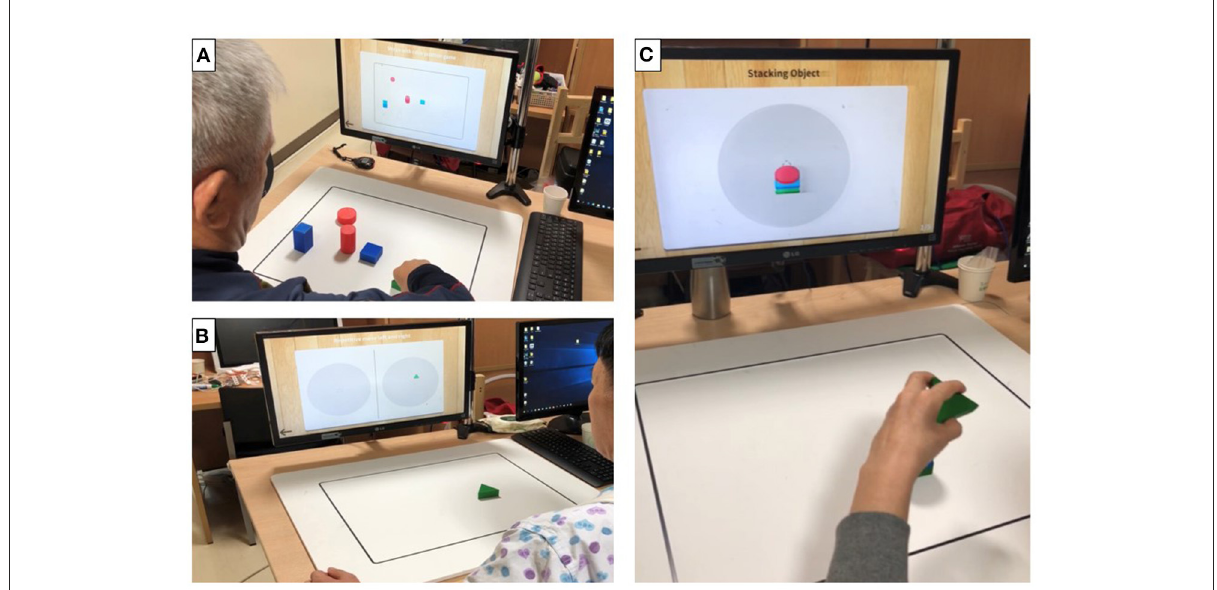
FIGURE3 Photographs of actual training using the objects in mixed reality (MR)-board training. The photographs show actual training using objects. Visual feedback was provided to the patients through a monitor that reflected the position of the object on the board. (A) “Matching the same shape” involved positioning of six objects correctly while comparing those displayed on the monitor. (B) “Moving the object” involved moving specific objects to the right and left repetitively. (C) “Stacking the objects” involved stacking objects on top of one another, without them collapsing, according to the shape shown on the